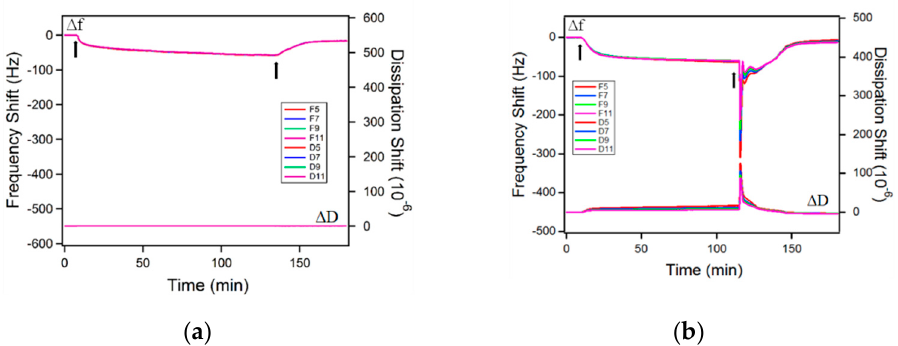
Figure 6. Δ f and Δ D over time of a gold sensor surface responding to exposure to ( a ) 0.1 wt.% P.R. rhamnolipid aqueous solution and ( b ) 0.1 wt.% P.R. rhamnolipid in 3.5 wt.% NaCl aqueous solution. The first arrow indicates the time when the rhamnolipid solution was injected and the second arrow indicates the time when solvent rinsing was initiated. Fi and Di shown in the insert are the frequency and dissipation at i th overtone, respectively.